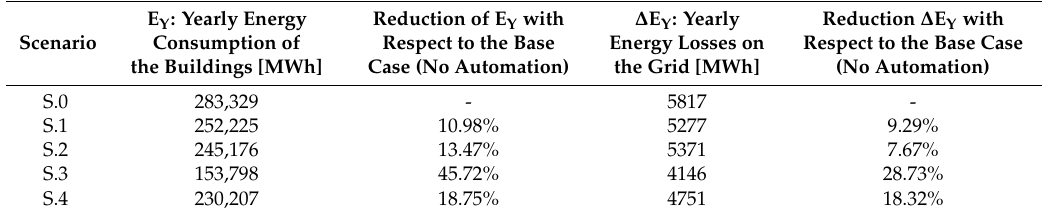
Table 7. Rome: Energy consumptions and losses for the different control logics (Presence of FV).